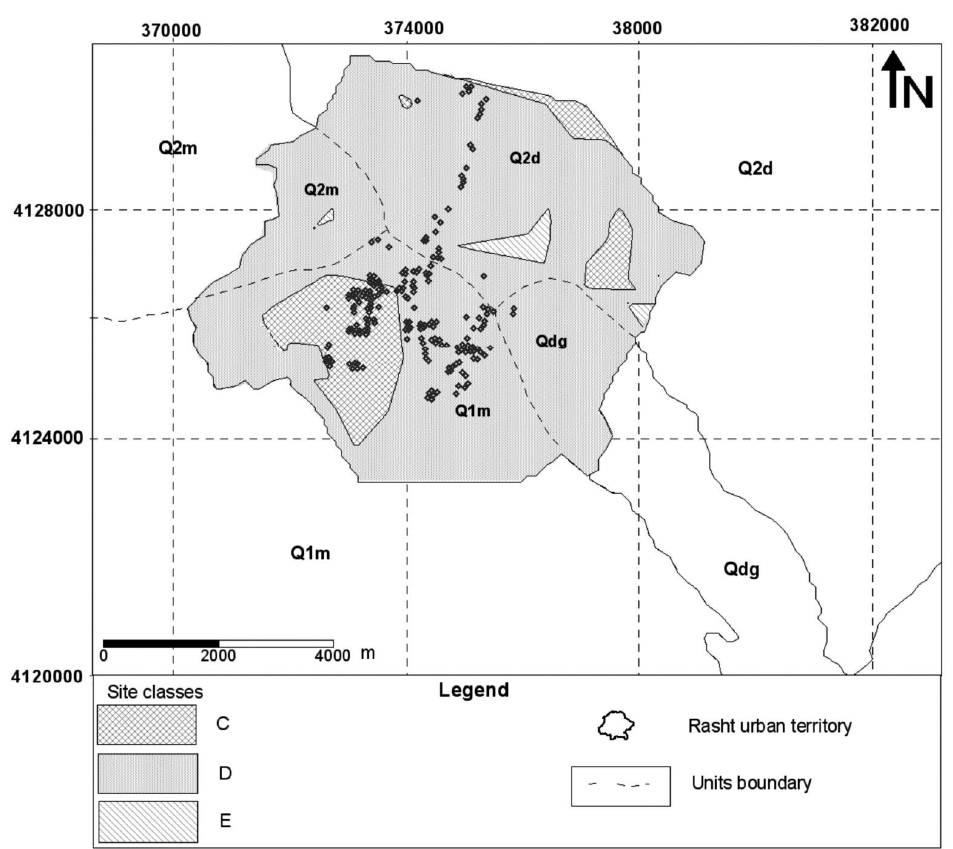
Fig. 11. Distribution of in